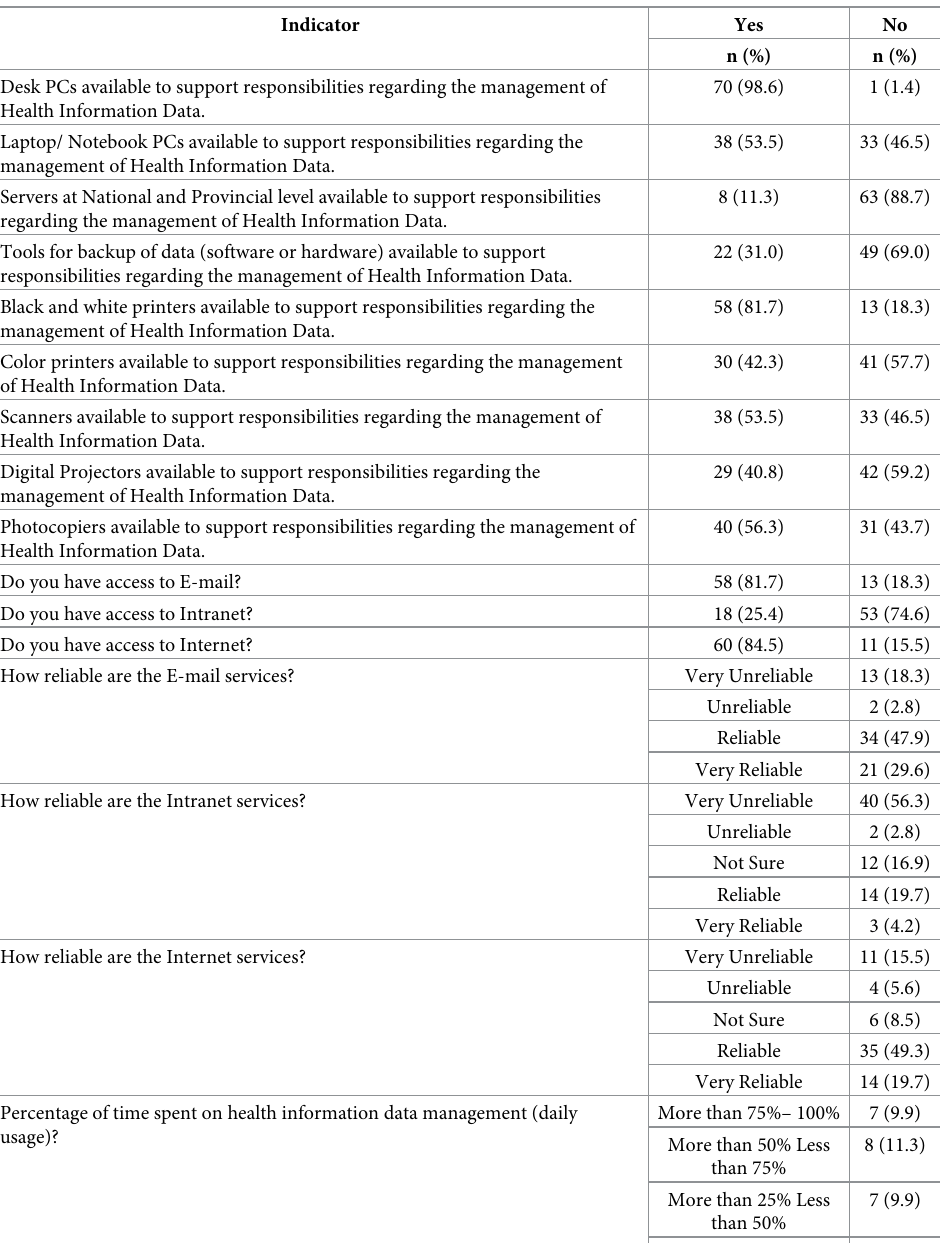
Table 2. Availability of resources for management of HIS. Indicator Yes No